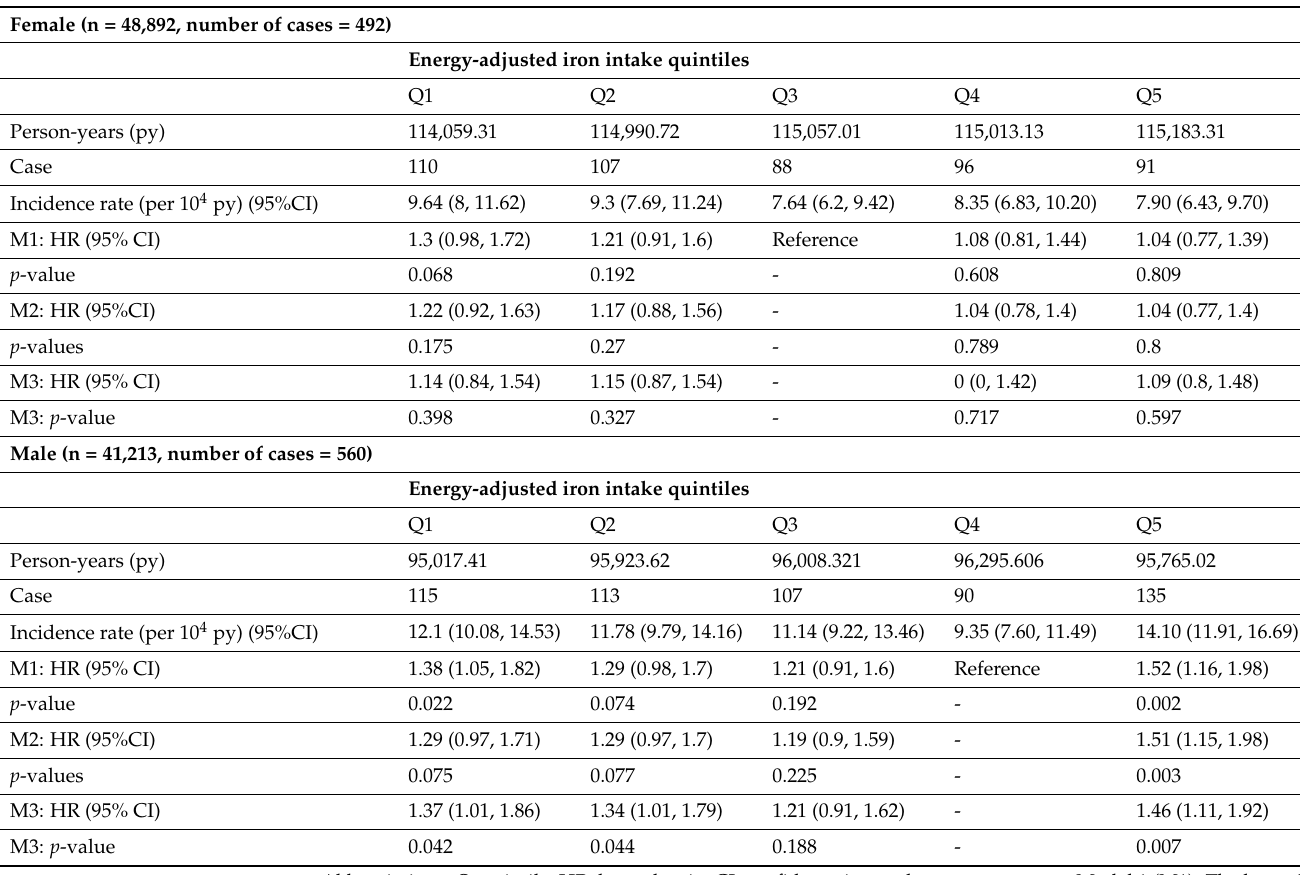
Table 2. Risk for all-cause dementia associated with iron intake in females and